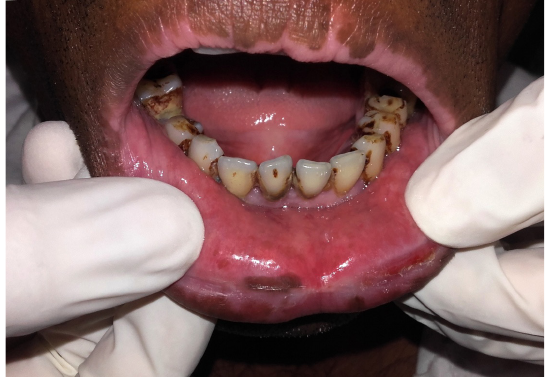
Figure 1: Ulcerated lower lip and Depapillated tongue.